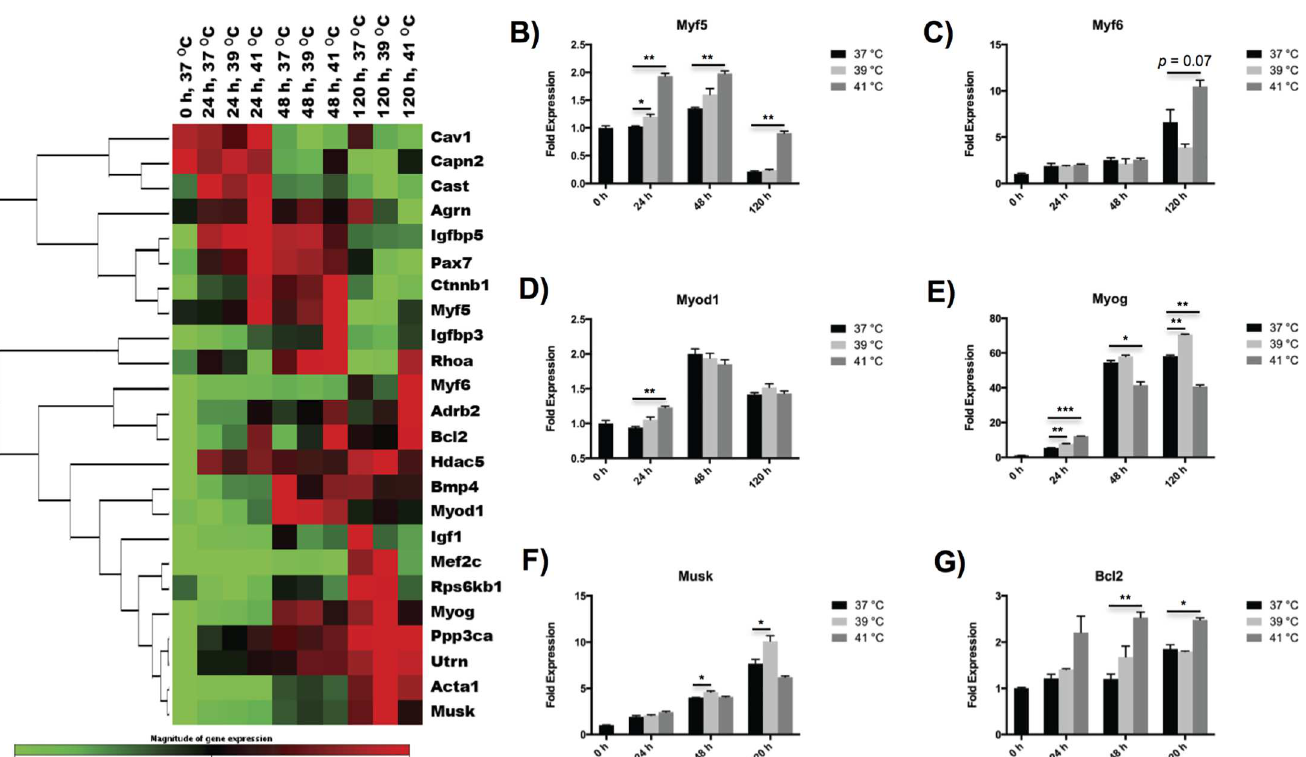
PLOS ONE | DOI:10.1371/journal.pone.0166294 November 8,